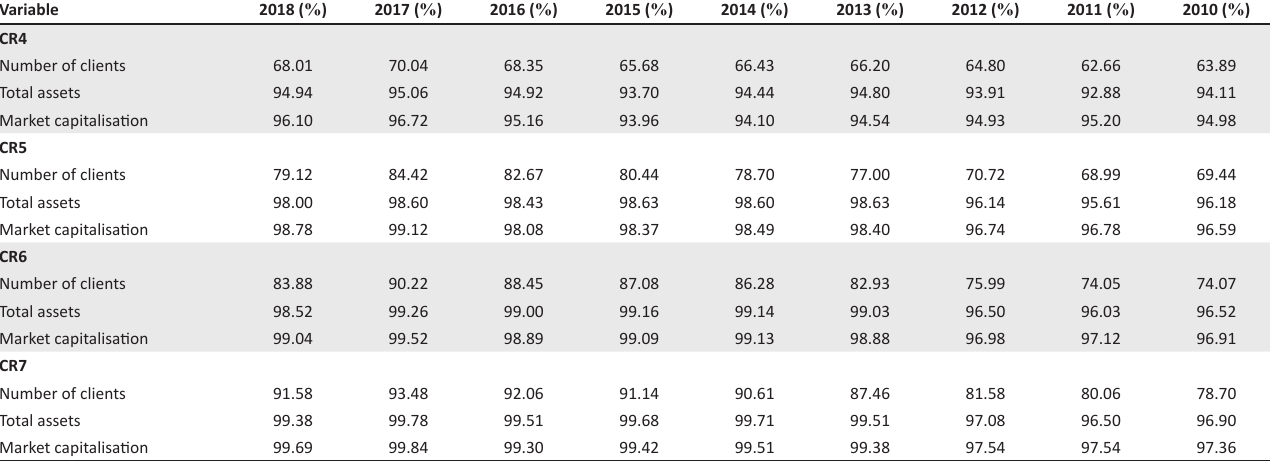
TABLE 3: Concentration ratios of the South African audit market.